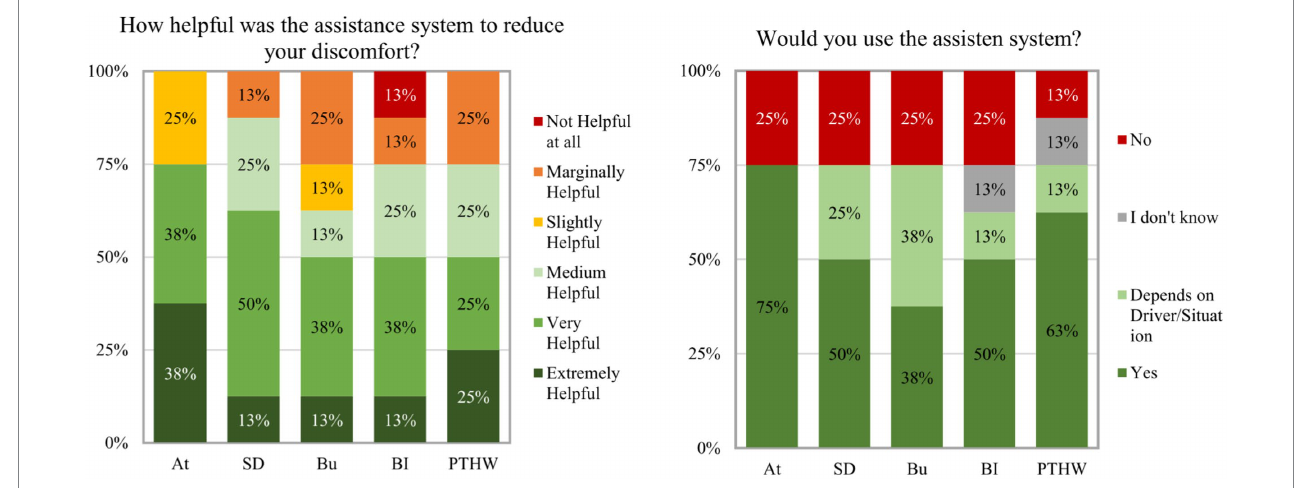
FIGURE 13 Left: Helpfulness ratings for the different assistance systems made in the post inquiry. Right: Reported intention to use the experienced assistance